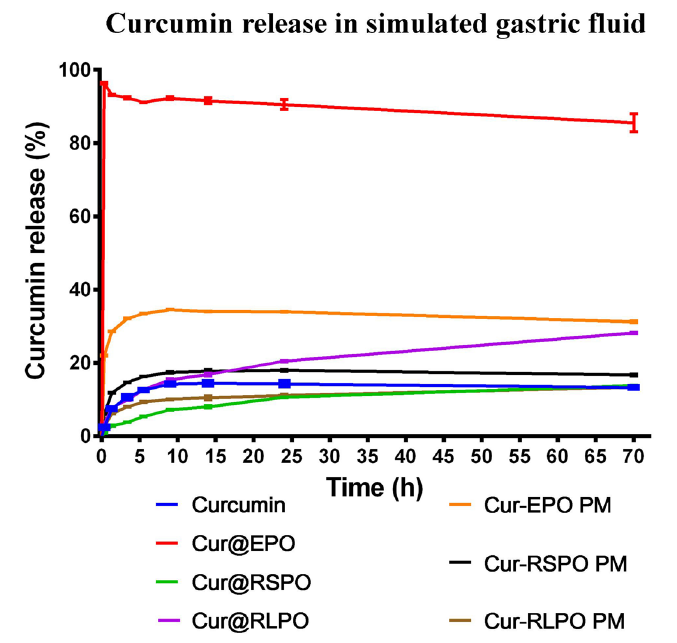
FIGURE 5 - Release profile in simulated gastric fluid (SGF) of curcumin, curcumin Eudragit E PO solid dispersion, curcumin Eudragit RS PO solid dispersion, curcumin Eudragit RL PO solid dispersion, curcumin and respective acrylic polymer including curcumin Eudragit E PO physical mixture (Cur-EPO PM), curcumin Eudragit RS PO physical mixture (Cur-RSPO PM) and curcumin Eudragit RL PO physical mixture (Cur-RLPO PM). Each text was repeated three